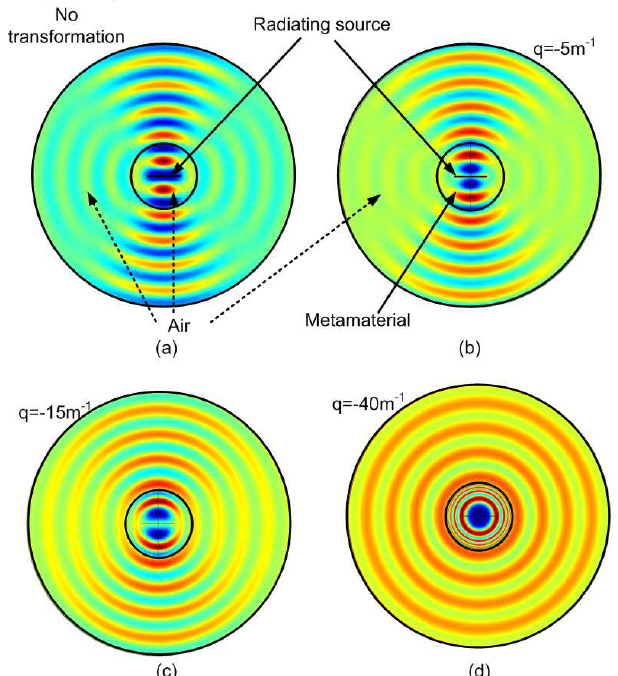
Figure 12: Simulated electric field distribution for a TE wave polarization at 4 GHz. (a) current plane source used as excitation for the transformation. The current direction is perpendicular to the plane of the figure; [(b)-(d)] verification of the transformation for different values of expansion factor q .